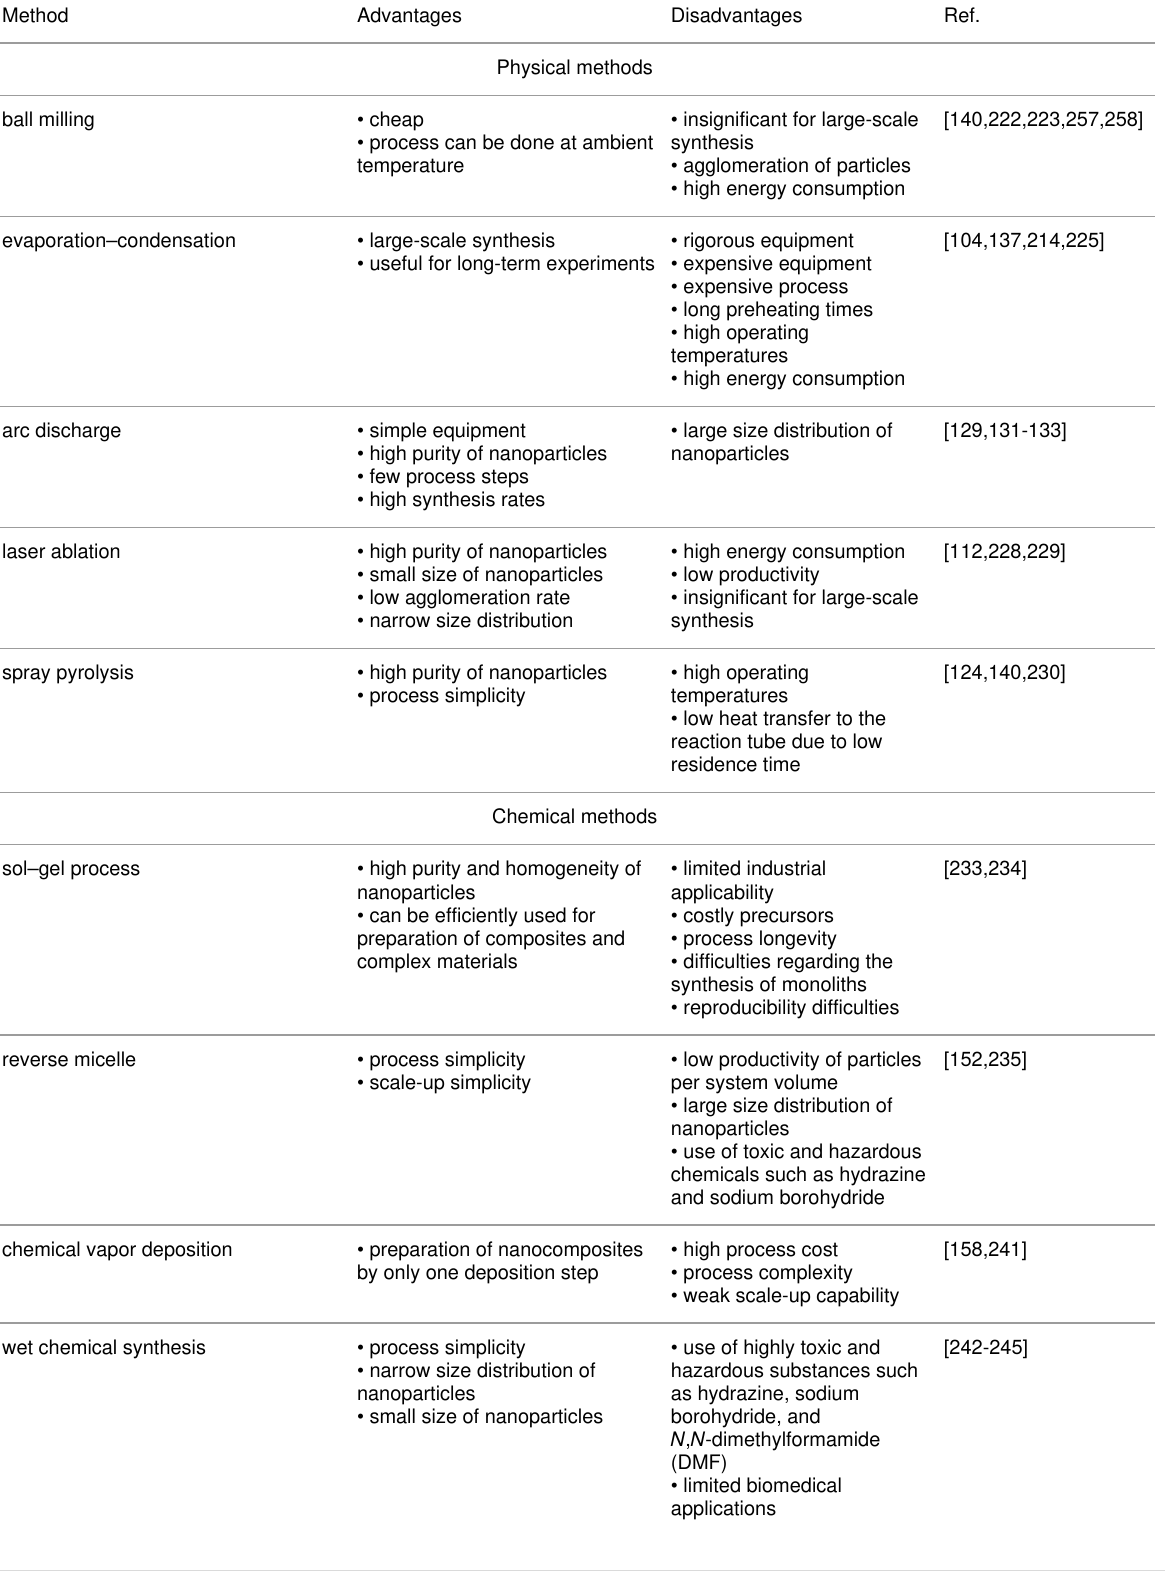
Table 1: Classification and comparison of various synthesis methodologies of silver nanostructures based on their advantages and disadvantages as reported in the literature.